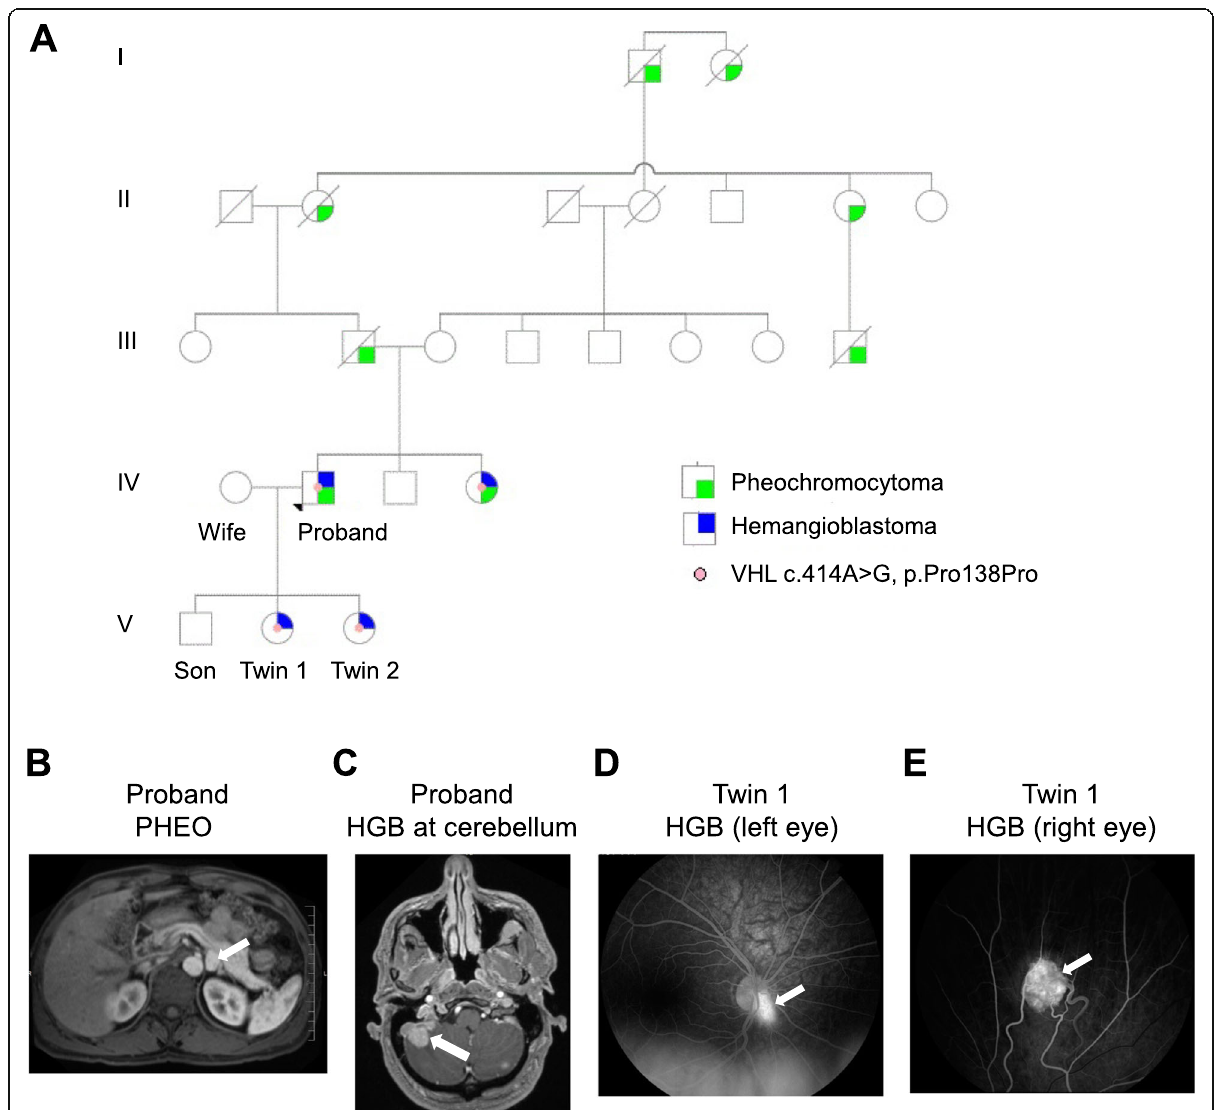
Fig. 1 Clinical findings of the VHL disease family. ( a ) Five-generation pedigree of the patient family shows that the synonymous VHL variant c.414A > G segregates with affected family members. ( b ) T2-weighted MRI shows PHEO in the left adrenal gland of the proband. ( c ) Axial T1- weighted post contrast MRI shows the HGB in the right cerebellum of the proband. (D-E) Fluorescein angiography shows the retinal HGB in the left and right eye of Twin 1. In all images, white arrows point to the